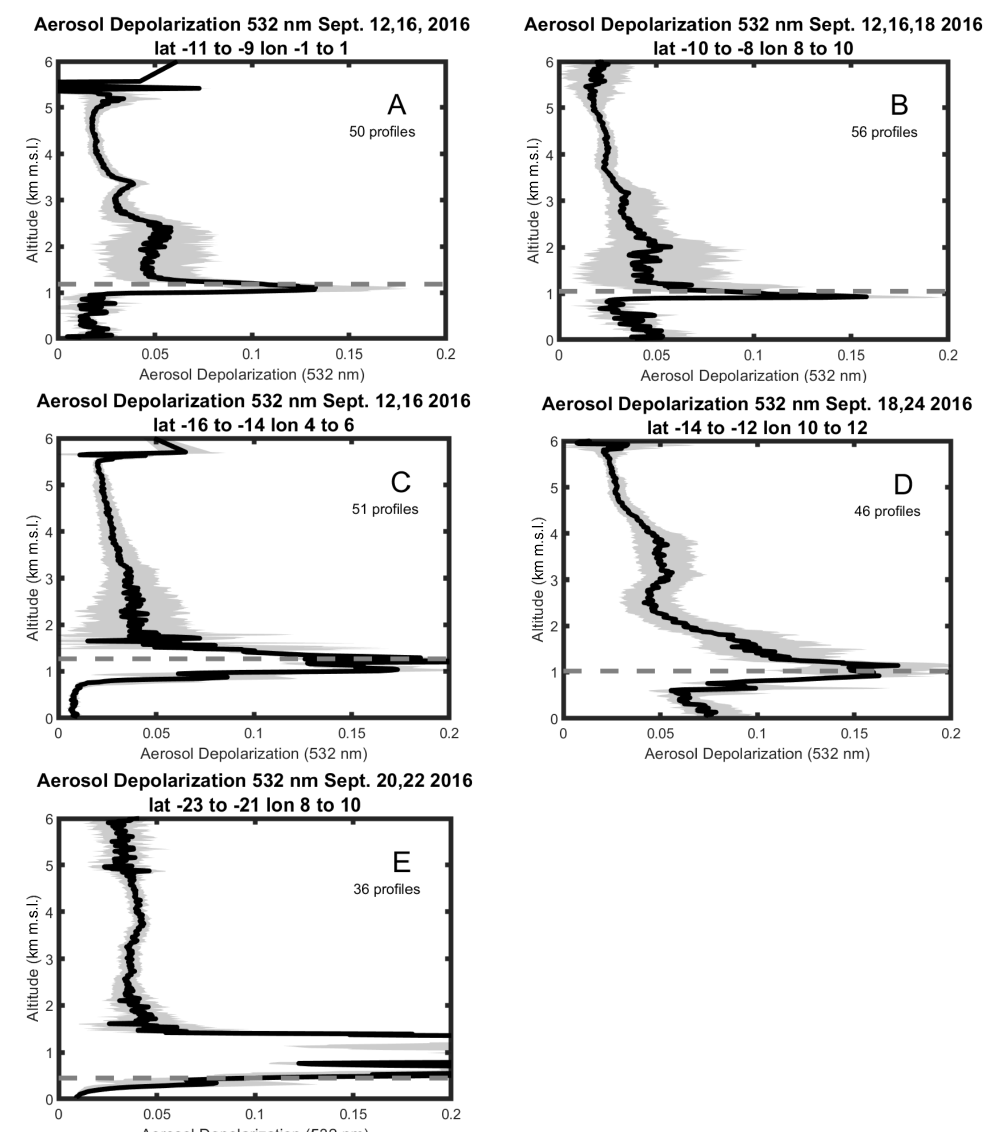
Figure 8. As in Fig. 6 but for the aerosol depolarization at